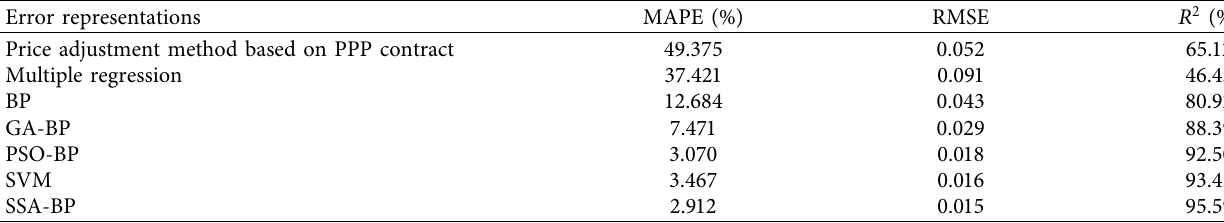
Table 8: Comparison of calculation results of different models with 8 input variables.